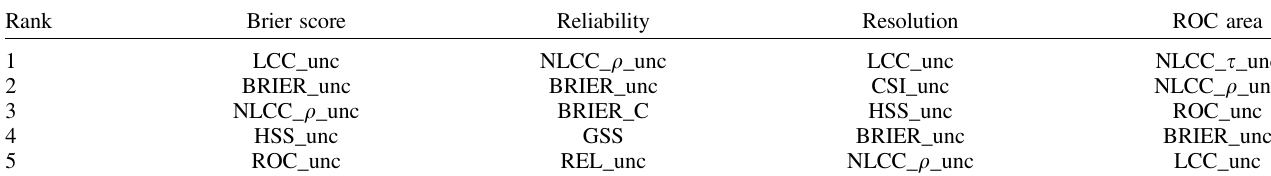
Table 4. Rankings of evaluation metrics for M-class fl are forecasts. For each metric top fi ve ensembles are displayed. Rank